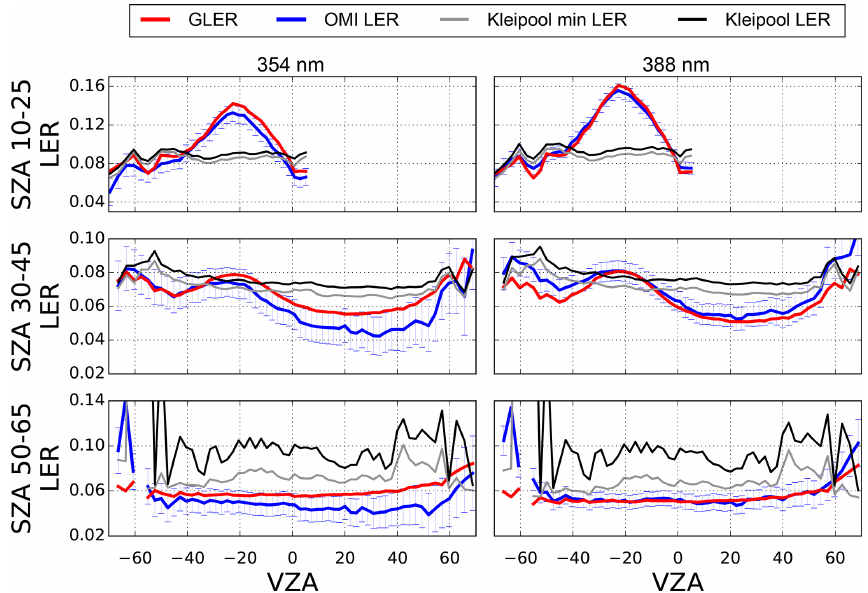
Figure 3. January 2006 LER as a function of VZA for select SZA ranges at 354 and 388nm over the Pacific Ocean (only deep ocean pixels considered). The blue error bars represent the 2% calibration uncertainty of OMI (Dobber et al., 2008). Negative VZAs represent the west side of the OMI swath (forward scattering), whereas positive VZAs represent the east side of the OMI swath (backward scattering). Data are screened for clouds with the Raman-based ECF and aerosols are removed with the OMAERUV AI.